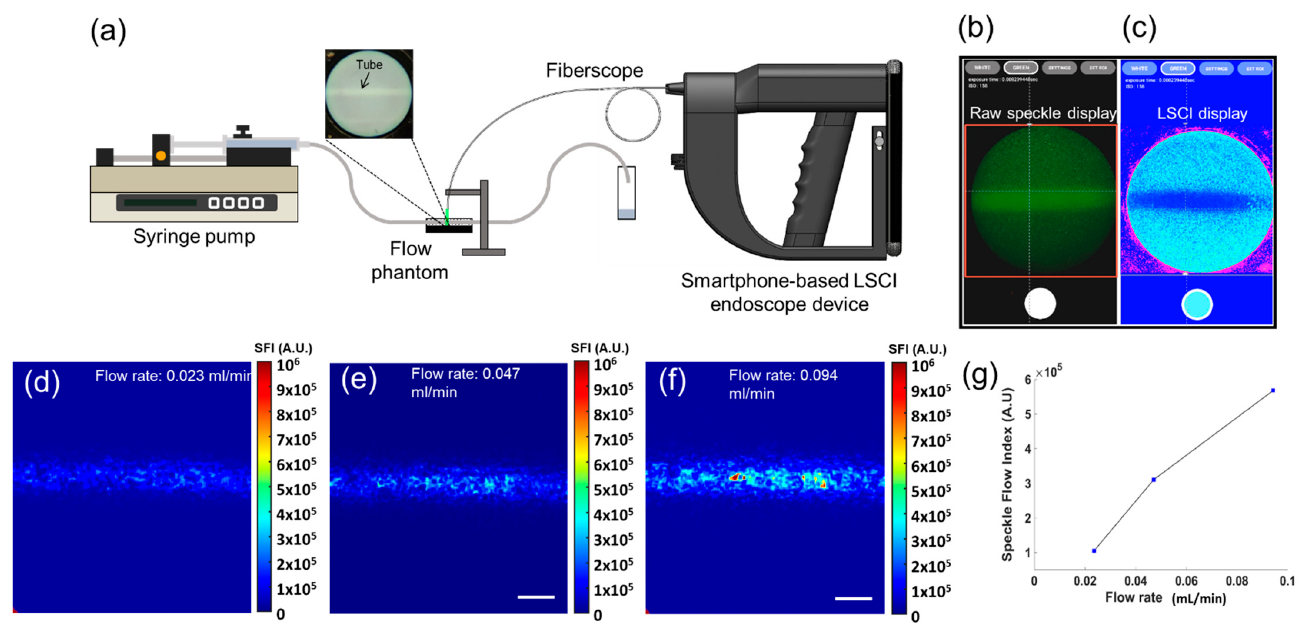
Figure 4. Tissue-mimicking phantom flow imaging with the smartphone-based LSCI endoscope device: ( a ) experimental setup of the phantom flow experiment; ( b ) raw speckle images of the phantom are displayed in real-time on the screen of the developed smartphone app; ( c ) laser speckle contrast images (K maps) computed with the raw speckle images displayed on the app at 30 FPS; ( d – f ) Speckle flow index (SFI) images of the phantom flow at different flow rates: 0.023 mL/min ( d ), 0.047 mL/min ( e ), and 0.094 mL/min ( f ); ( g ) a plot of the calculated SFIs with different flow speeds. Scale bars: 0.5 mm.